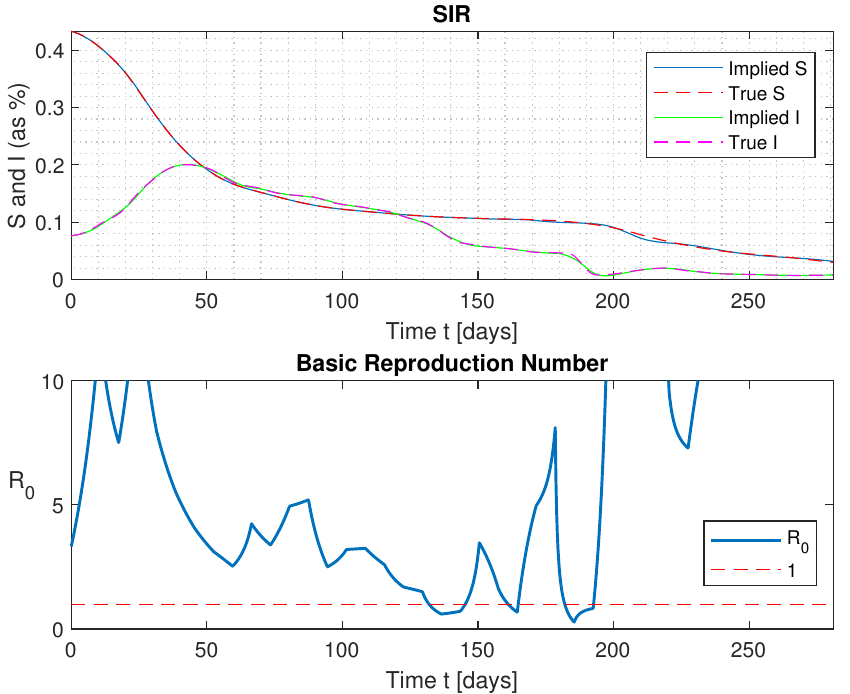
Figure 9. Recovered and observed susceptible S and infected I population ( top ) and the basic reproduction number R 0 ( bottom ) for α =